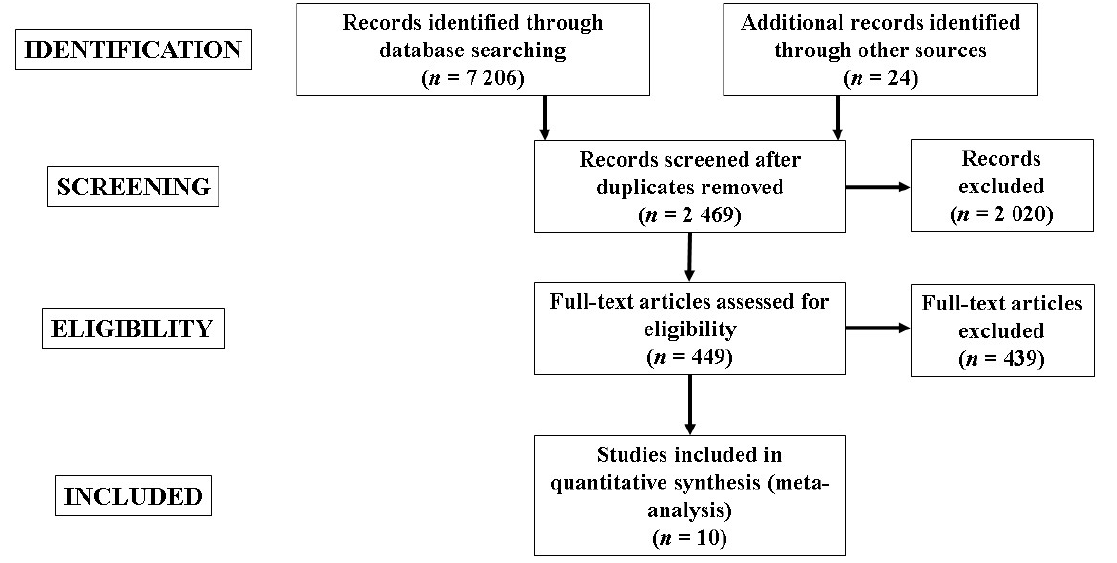
Figure 1. Flow diagram of the search process.